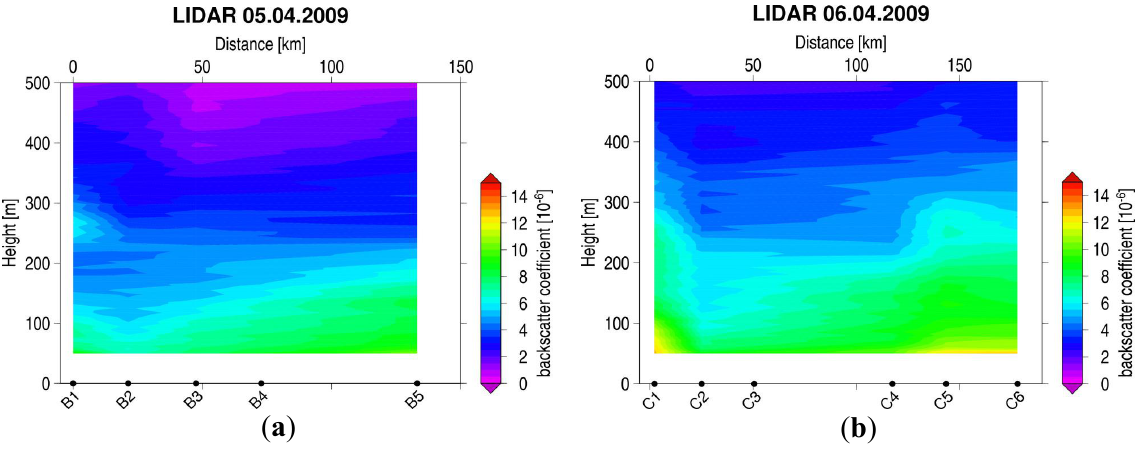
Figure 12. Lidar measurements of the backscatter coefficient on 5 ( a ) and 6 ( b ) April